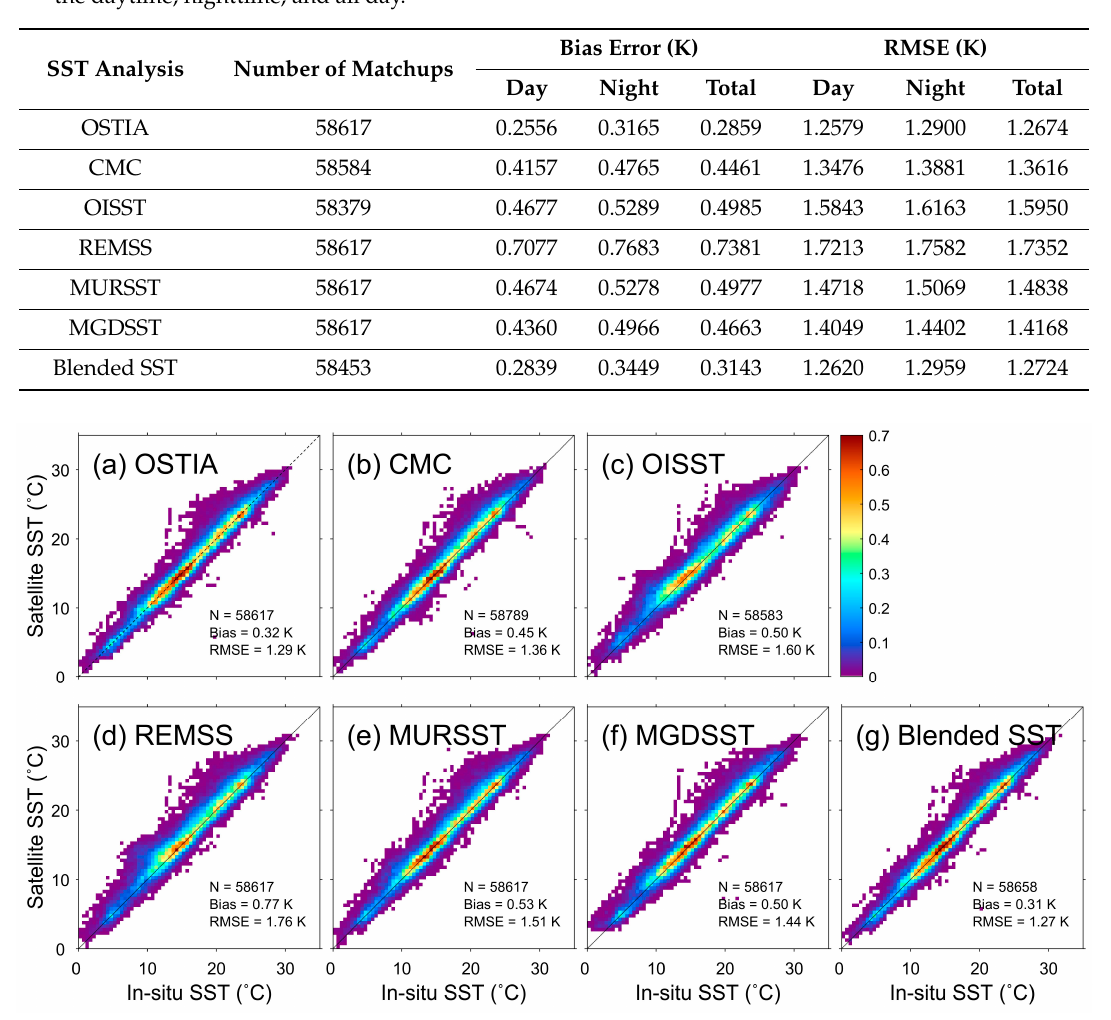
Figure 3. Comparison between sea surface temperature (SST) analyses and in-situ temperatures from coastal wave buoys—( a ) OSTIA; ( b ) CMC analysis; ( c ) OISST; ( d ) REMSS analysis; ( e ) MURSST; ( f ) MGDSST; and ( g ) Blended SST. The color represents the percentage of the data to the total number of matchup points in a bin of 0.5 × 0.5 K. The number of matchups (N), bias errors, and root-mean-squared errors (RMSEs) are given in each